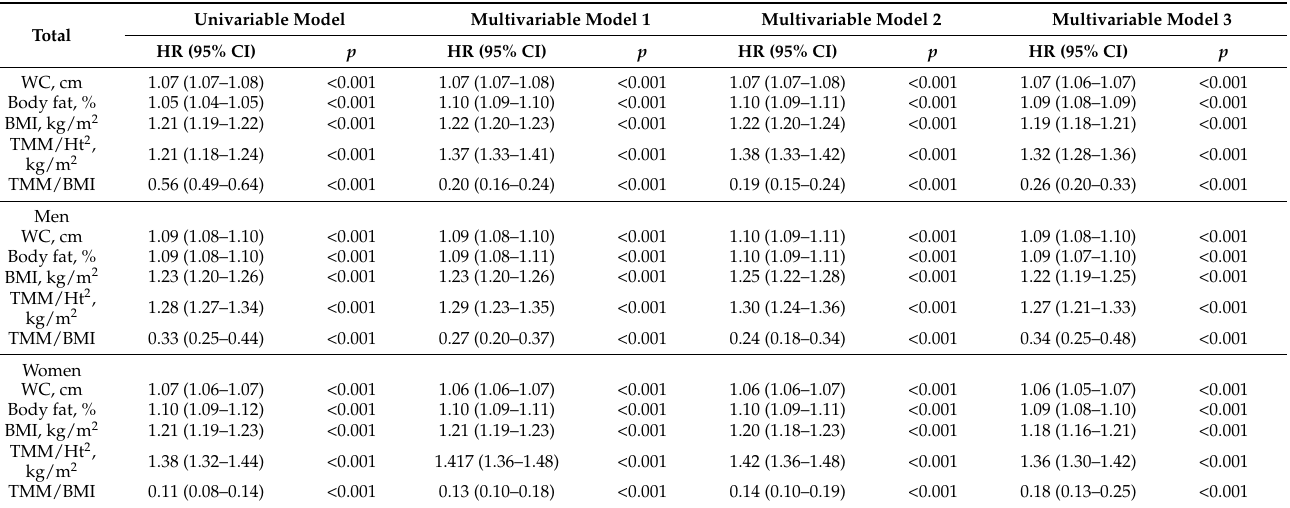
Table 2. Hazard ratio and 95% confidence interval for incident non–alcoholic fatty liver diseases according to five body composition